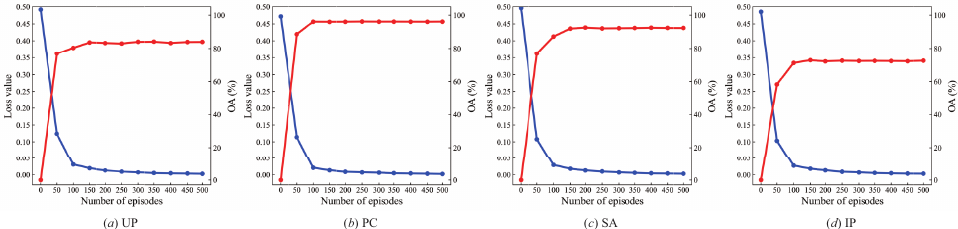
Figure 10. Curves of loss value and OA during fast adaption to different target HSIs. The red and blue curves represent OA and loss value, respectively.